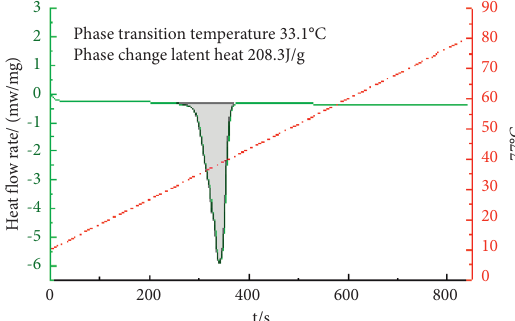
Figure 7: TD-MA :LA is the DSC curve of TD-MA-LA at 6.3:3.7.